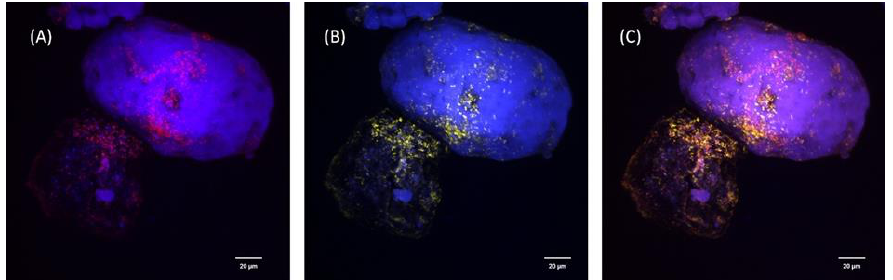
Figure 6. Adhesion of reference USK1 strain ( A ) or native strain ( B ) and merged imagines ( C ) onto the ore particle surface. Bacteria were labeled with quantum dots: red USK1 and yellow HK4.